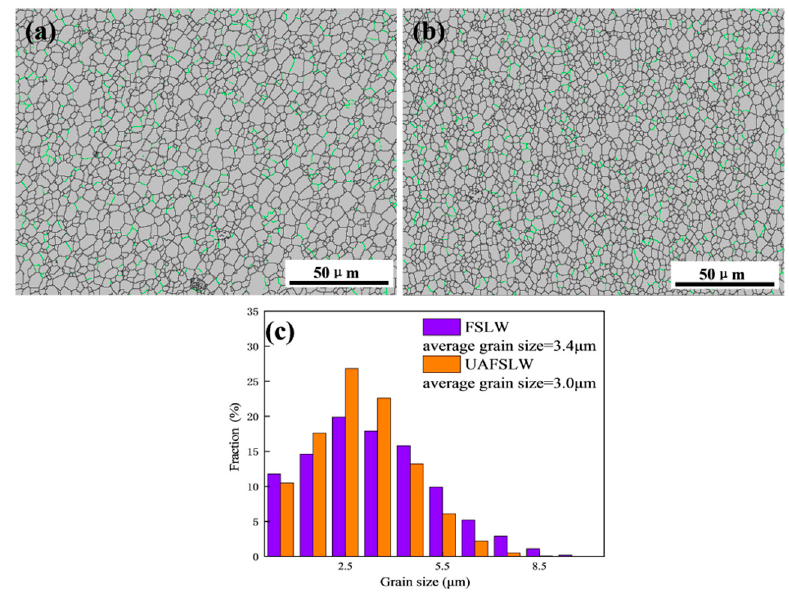
Figure 10. Grain boundary maps in the stirred zone (SZ) of FSLW and UAFSLW joints welded by tool T2: ( a ) FSLW, ( b ) UAFSLW, and ( c ) grain size distribution.